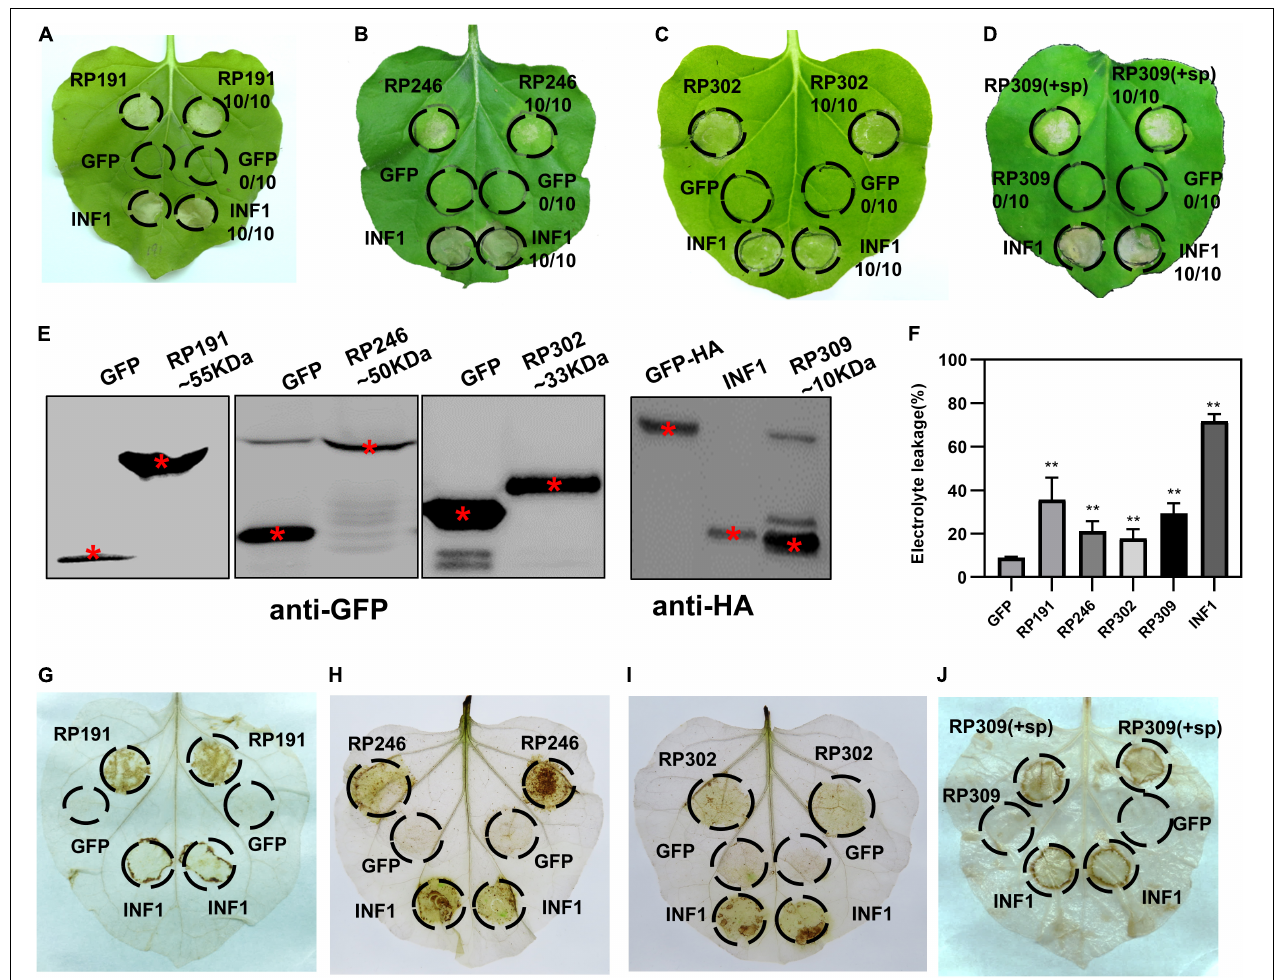
FIGURE 3 | Identification of necrosis-inducing proteins (NIPs) in Nicotiana benthamiana . (A–D) Necrosis inducing proteins (NIPs) induce cell death in N. benthamiana leaves. Green fluorescent protein (GFP) was used as the negative control and INF1 was the positive control. GFP, GFP-NIPs, and INF1 were expressed in N. benthamiana leaves via agroinfiltration. The leaves were photographed at 4 days after agroinfiltration. All experiments were repeated 10 or more times. (E) Immunoblot analysis of GFP, NIPs, and INF1 expressed in N. benthamiana . Red asterisks indicated the right protein bands. (F) Quantification of electrolyte leakage in N. benthamiana leaves expressing NIPs. All the experiments were replicated three times and then analyzed using Student’s t -test (** P < 0.01). (G–J) ROS accumulation associated with each NIP. DAB staining was performed at 2 days after infiltration on leaves containing GFP, INF1, and